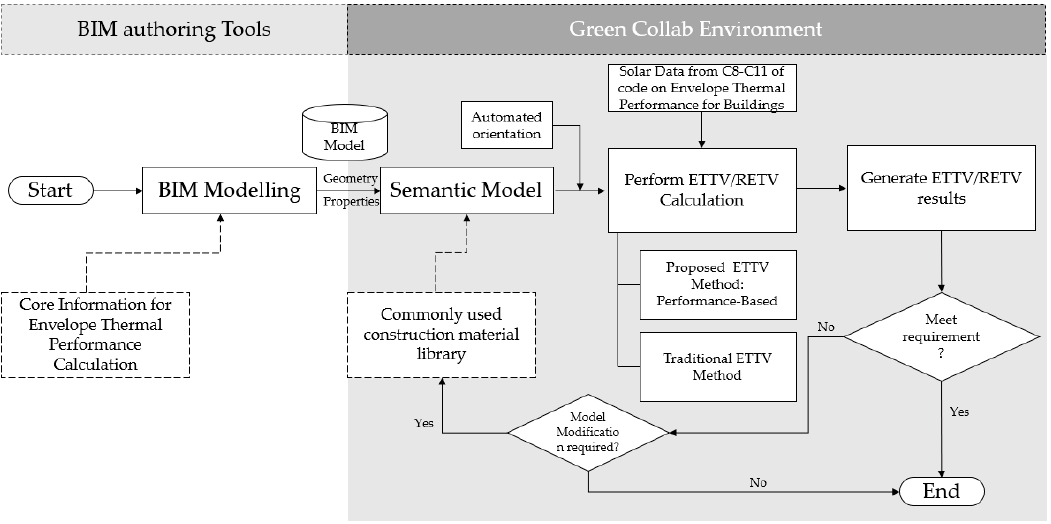
Figure 2. Proposed workflow for Building Information Model (BIM)-based ETTV computation.